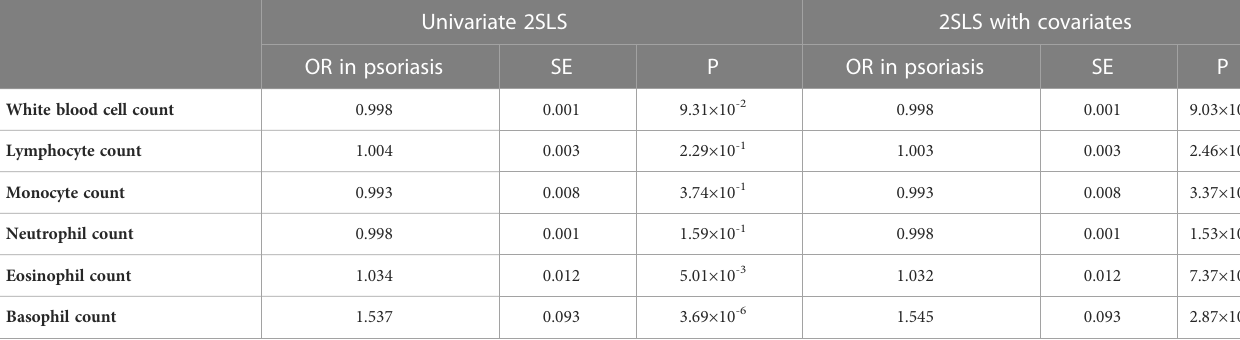
TABLE 2 One-sample MR results of white blood cells and psoriasis in UKB.